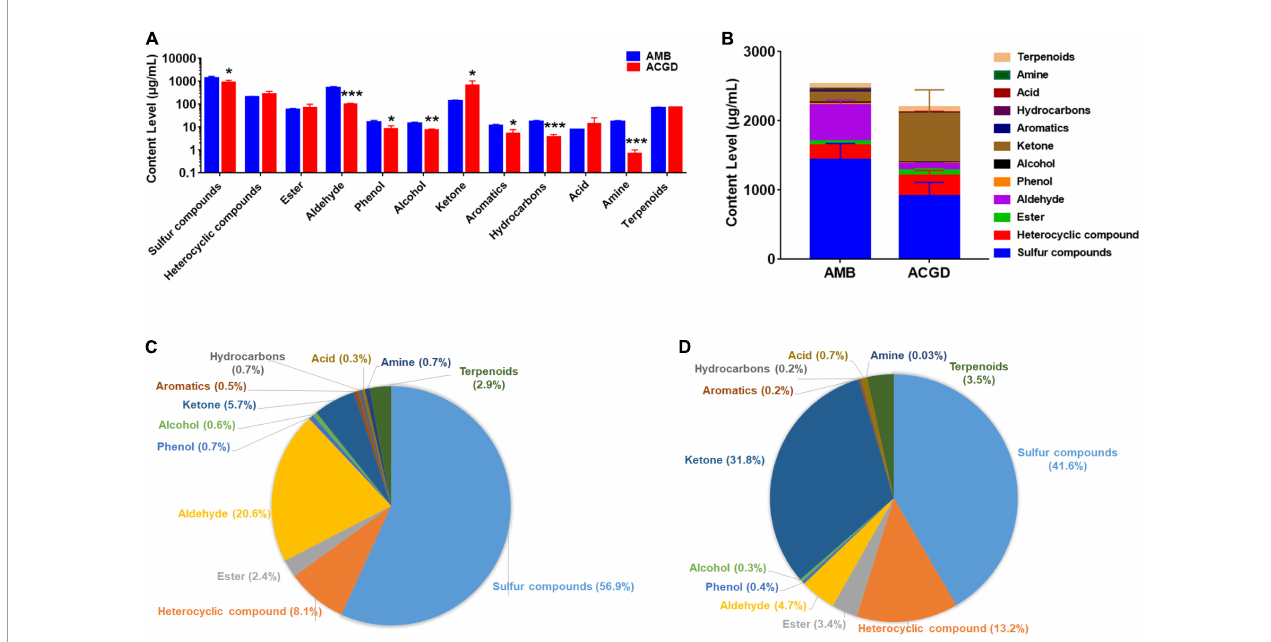
FIGURE6 The comparison of content levels of holistic volatile organic compounds (VOCs) in Allium macrostemon Bge. (AMB) and Allium chinense G. Don (ACGD). Content comparison of multiple types of VOCs (A) . The total content comparison of holistic VOCs (B) . The content proportion of multiple types of VOCs in AMB (C) and ACGD (D) . Error bars represented the standards deviations of three determinations ( n = 3) (* p < 0.05, ** p < 0.01, *** p < 0.001).